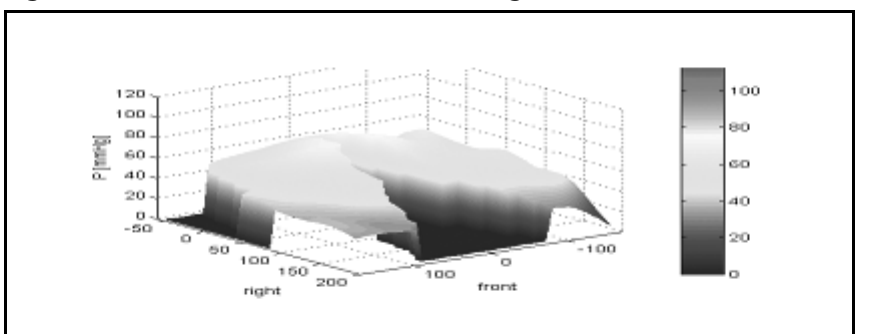
Figure 7: Silicon Gel cushion: Neutral